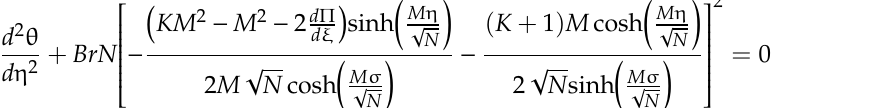
Table 3. E ff ect of ζ by fixing M = 1, K = 0.1, β = H o